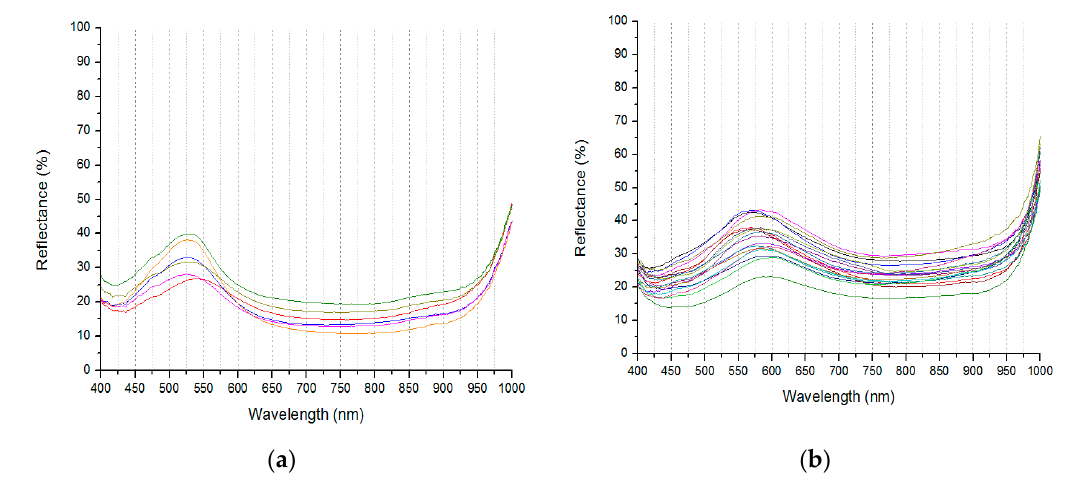
Figure 5. Diffuse reflectance spectra indicating differences regarding the reflectance maximum position and the reflectance intensity: ( a ) Late Bronze Age copper-based objects; ( b ) Early Bronze Age copper-based objects.